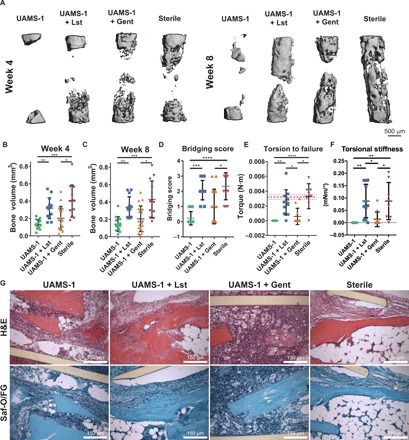
UAMS-1 infection defects treated with BMP-2–loaded lysostaphin-delivering hydrogels significantly improve bone repair.Representative μCT reconstructions at 4 and 8 weeks. (A) Quantification of bone volume from μCT imaging at 4 (B) and 8 (C) weeks after implantation. Kruskal-Wallis test with Dunn’s multiple comparisons test. Means ± SD. n = 12 to 18 per group. *P < 0.05, **P < 0.01, ***P < 0.001. (D) Defect bridging was assessed semiquantitatively using the following scale: 0, no bone formation; 1, less than half of the defect; 2, greater than half of the defect; 3, defect bridged. Kruskal-Wallis with Dunn’s multiple comparisons test. n = 12 to 18 per group. *P < 0.05, ***P < 0.001, ****P < 0.0001. (E) Functional healing was assessed using torsion to failure testing. The average torsion to failure values for healthy mouse radii are plotted as horizontal red lines (0.0032 ± 0.0003 N·m), as reported by Shekaran et al. (F) Torsional stiffness was then calculated for all samples. Means ± SD. n = 8 to 11 per group. One-way analysis of variance (ANOVA) with Tukey’s post hoc test for torsion to failure and Kruskal-Wallis with Dunn’s multiple comparisons test for torsional stiffness. (G) Mouse radii were sectioned and stained with H&E and safranin-O/fast green (Saf-O/FG). One sample was randomly selected and prepared per experimental group. Representative images are displayed.